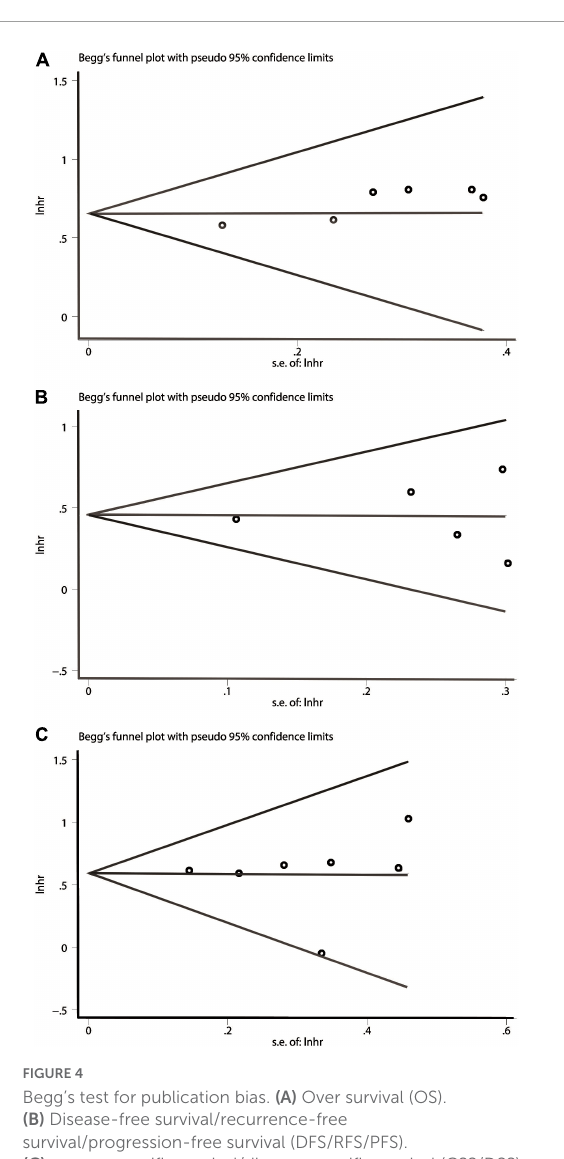
FIGURE4 Begg’s test for publication bias. (A) Over survival (OS). (B) Disease-free